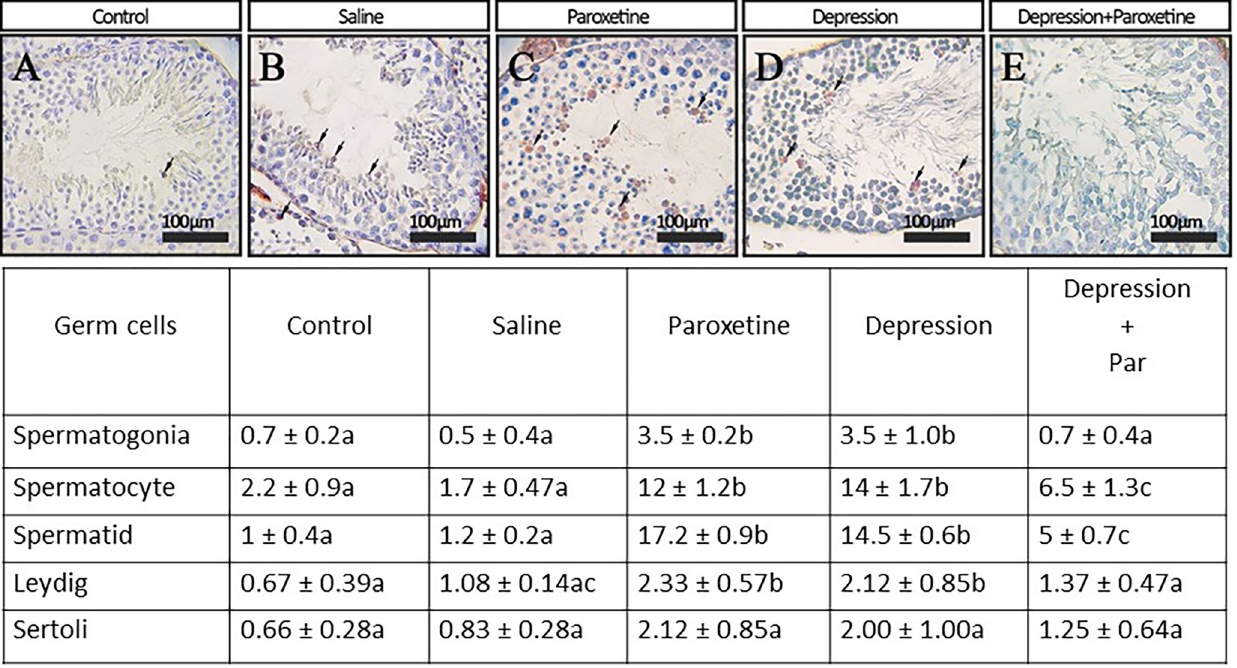
Fig 4. Immunohistochemical staining of TUNEL positive cells in testes cross-sections. Comparison of mean percentage of TUNEL-positive cells (spermatogonia, spermatocytes, spermatids, Leydig, and Sertoli cells) within groups. The values with different superscript letters in each row are significantly different (p �